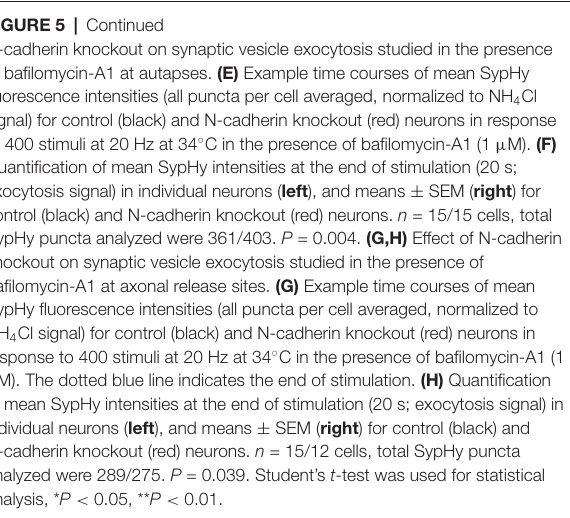
FIGURE 5 | Continued N-cadherin knockout on synaptic vesicle exocytosis studied in the presence of bafilomycin-A1 at autapses. (E) Example time courses of mean SypHy fluorescence intensities (all puncta per cell averaged, normalized to NH 4 Cl signal) for control (black) and N-cadherin knockout (red) neurons in response to 400 stimuli at 20 Hz at 34 ◦ C in the presence of bafilomycin-A1 (1 µ M). (F) Quantification of mean SypHy intensities at the end of stimulation (20 s; exocytosis signal) in individual neurons ( left ), and means ± SEM ( right ) for control (black) and N-cadherin knockout (red) neurons. n = 15/15 cells, total SypHy puncta analyzed were 361/403. P = 0.004. (G,H) Effect of N-cadherin knockout on synaptic vesicle exocytosis studied in the presence of bafilomycin-A1 at axonal release sites. (G) Example time courses of mean SypHy fluorescence intensities (all puncta per cell averaged, normalized to NH 4 Cl signal) for control (black) and N-cadherin knockout (red) neurons in response to 400 stimuli at 20 Hz at 34 ◦ C in the presence of bafilomycin-A1 (1 µ M). The dotted blue line indicates the end of stimulation. (H) Quantification of mean SypHy intensities at the end of stimulation (20 s; exocytosis signal) in individual neurons ( left ), and means ± SEM ( right ) for control (black) and N-cadherin knockout (red) neurons. n = 15/12 cells, total SypHy puncta analyzed were 289/275. P = 0.039. Student’s t -test was used for statistical analysis, * P < 0.05, ** P <